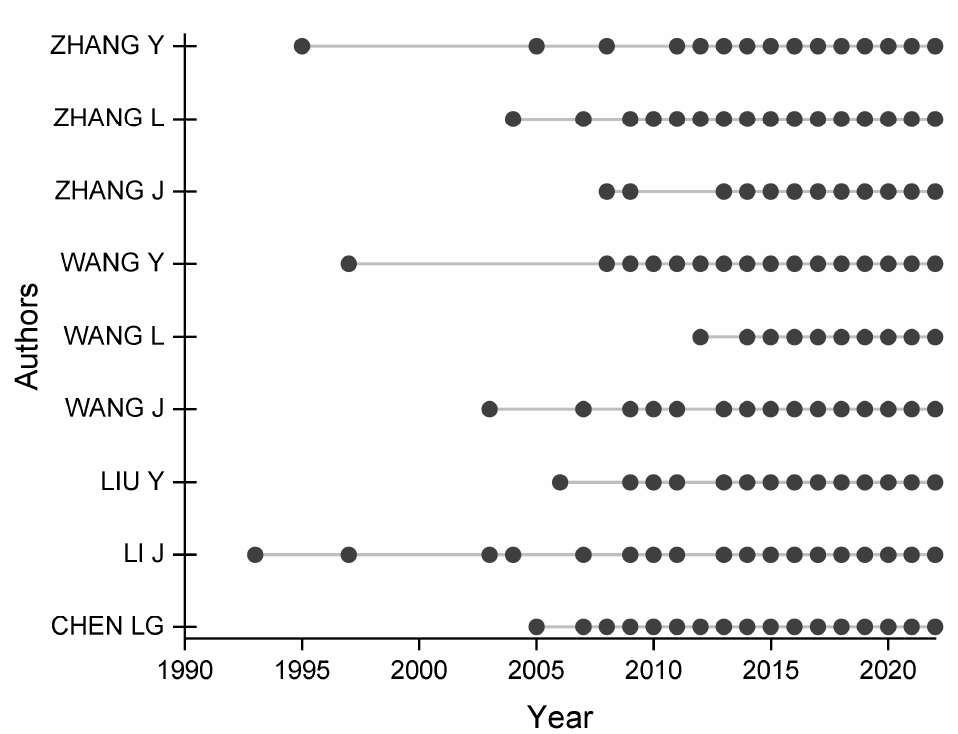
Figure 7. A summary of the author’s work over time (1993–2023).